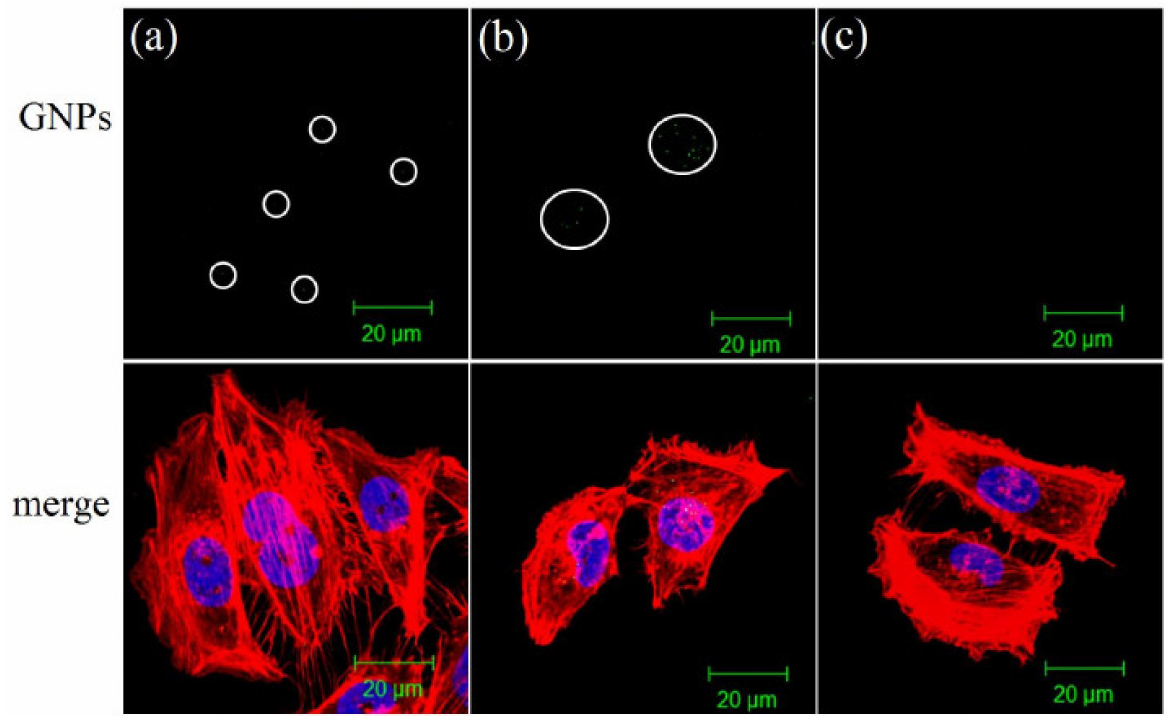
Figure 3. Laser scanning confocal microscope (LSCM) fluorescence images of MG63 cells after uptake of AuNPs. LSCM fluorescence images of ( a ) MG63 cells treated with AuNPs at a concentration of 1 ppm, ( b ) 10 ppm, and ( c ) normally cultured cells. Cytoskeletal F-actin (red) were stained with Texas Red-X phalloidin. Cell nuclei (blue) were stained with Hoechst 33258. The green spots in the circled areas are AuNPs. Reproduced from [47] under Creative Commons Attribution